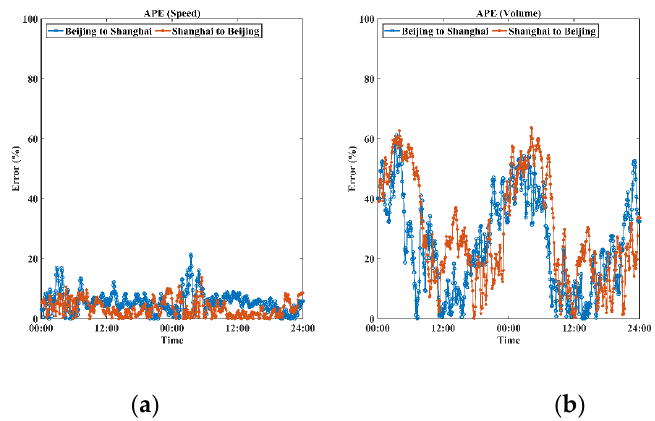
Figure 6. Details of absolute percentage errors over time for speed ( a ) and volume ( b ) between loop data and outputs of the Wi-Fi signal-based system.